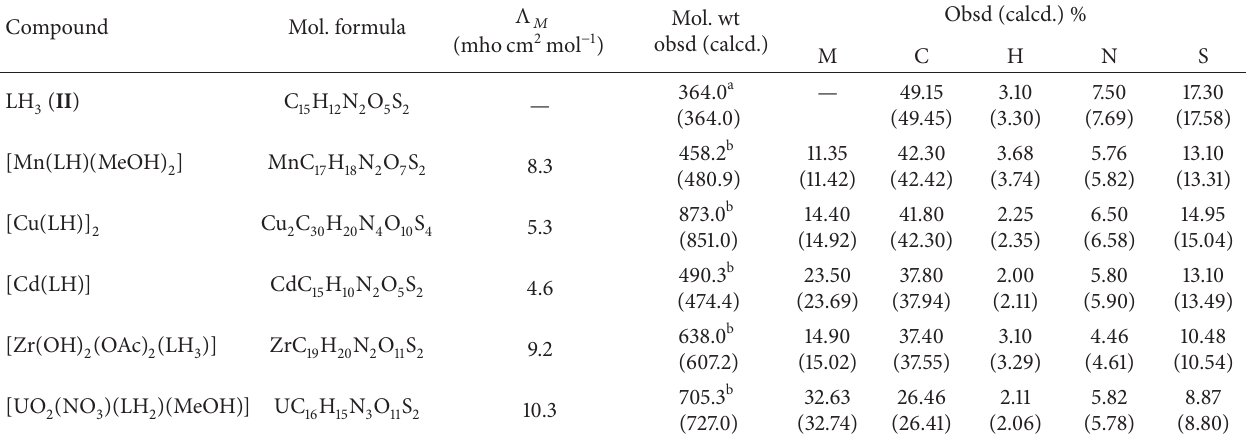
Table 1: Analytical, molar conductance ( Λ 𝑀 ), and molecular weight data of II and its coordination compounds.